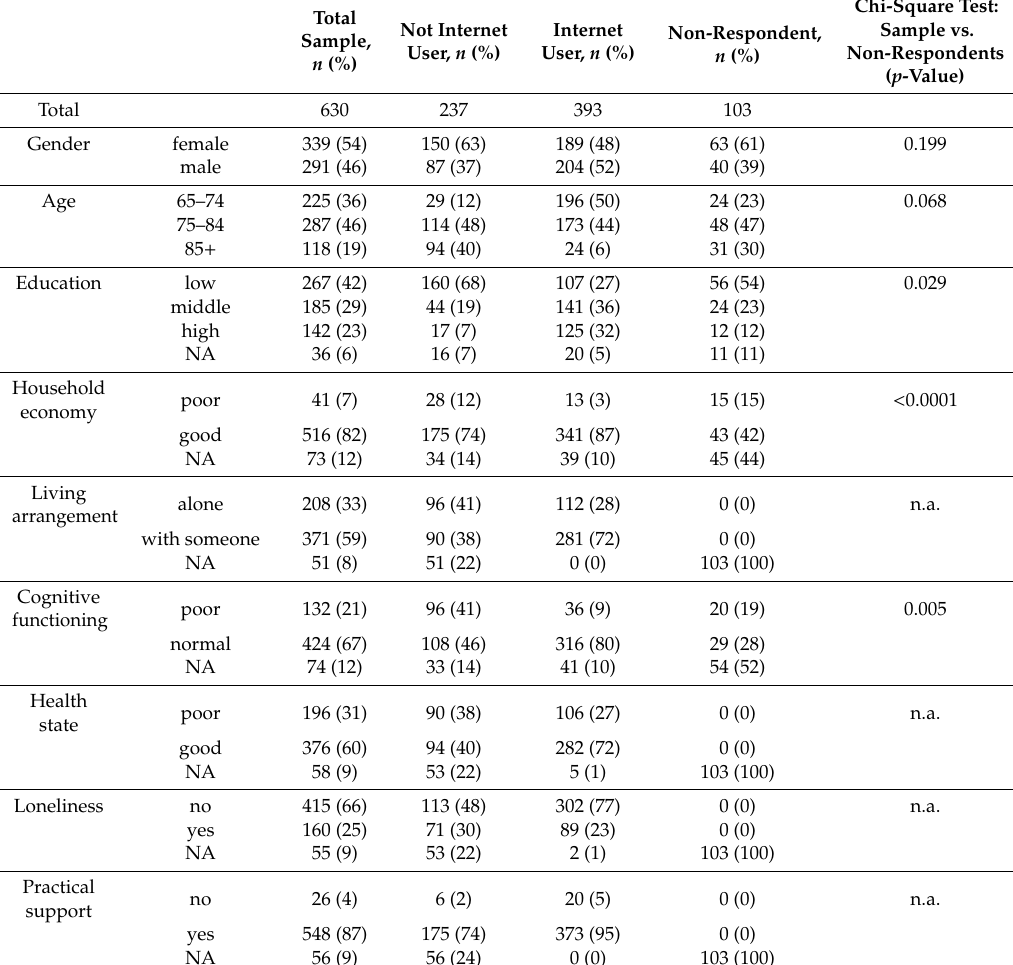
Table 2. Characteristics of the sample ( n = 630) and the excluded persons ( n = 103).